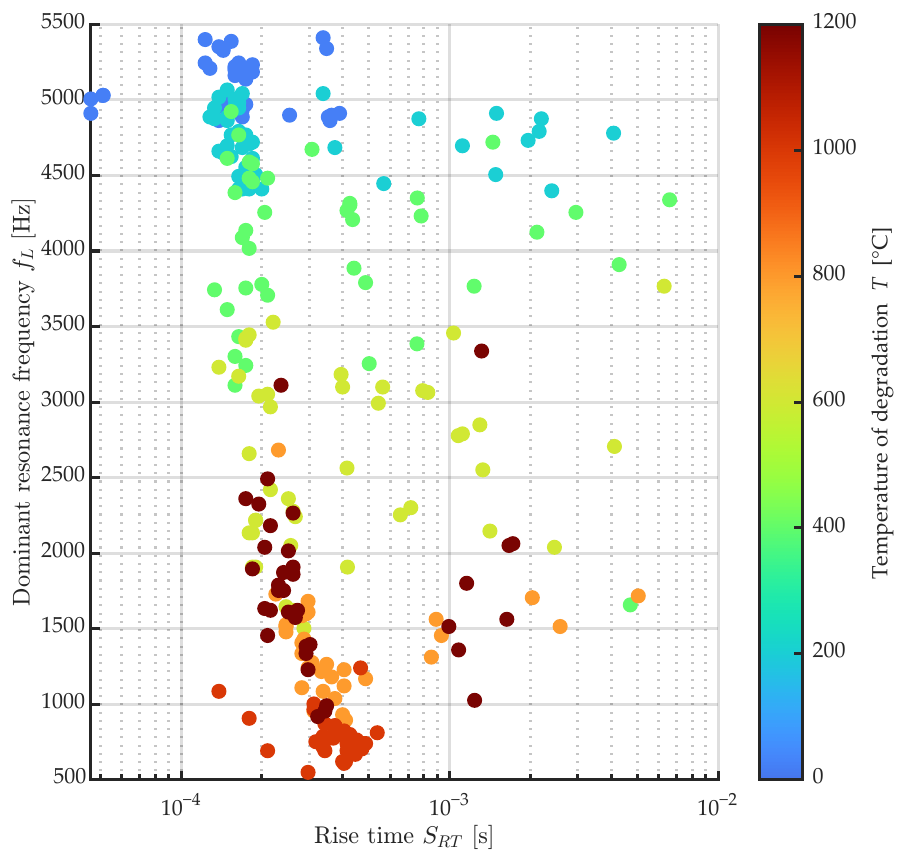
Figure 11. Dependency of parameter longitudinal resonance frequency f L on a rise time RT of signals of all mixtures across the temperature sets 20–1200